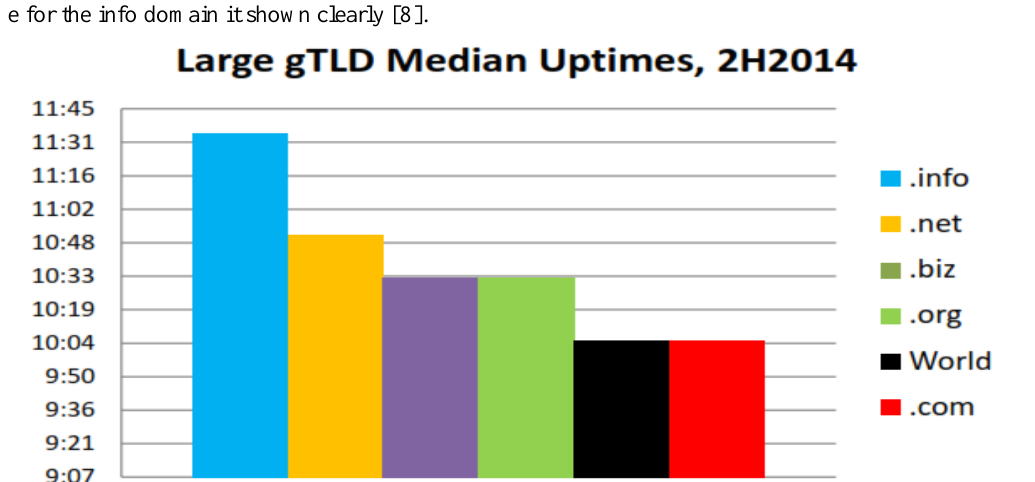
Figure. 2 Shows the peak time of Phishing Attacks in the Second Half of 2014 Based on